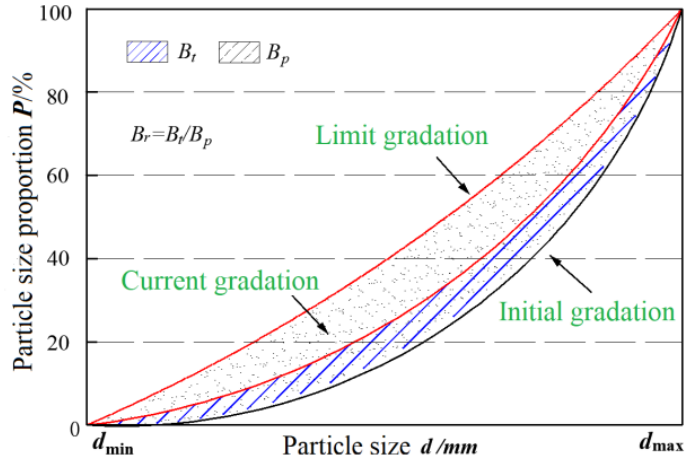
Figure 10. Schematic representation of the grading curve.